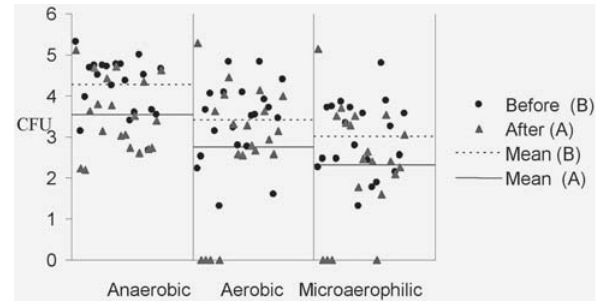
FIGURE 2- Graphic representation of microorganism count logarithms in CFUs relative to Group 2